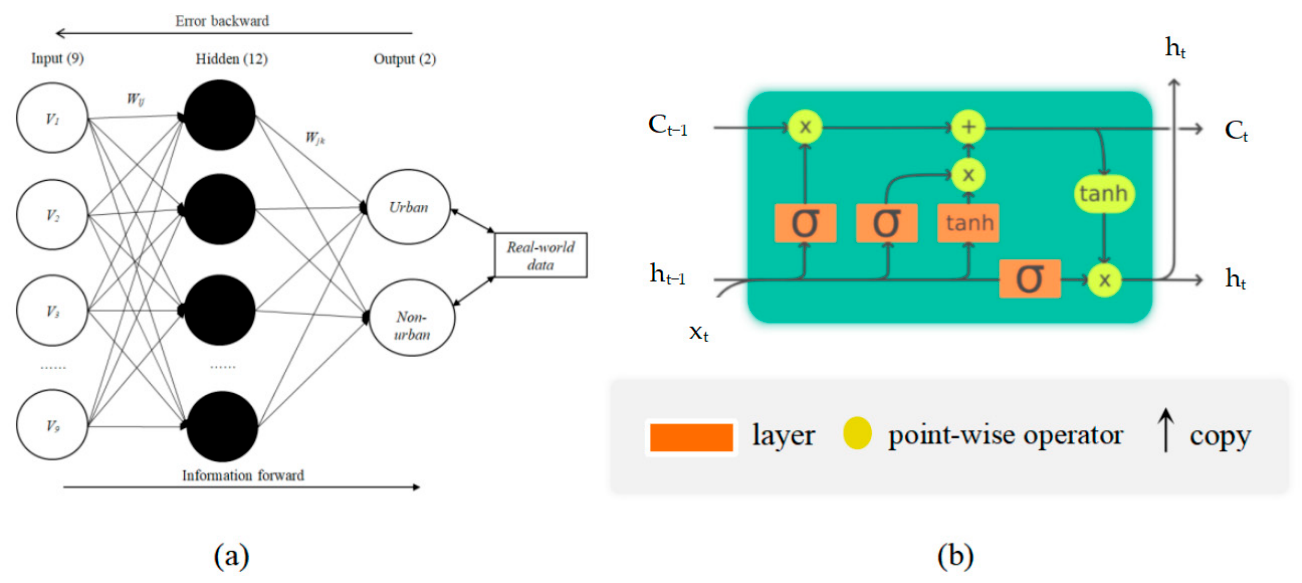
indicates the “forget” process for the